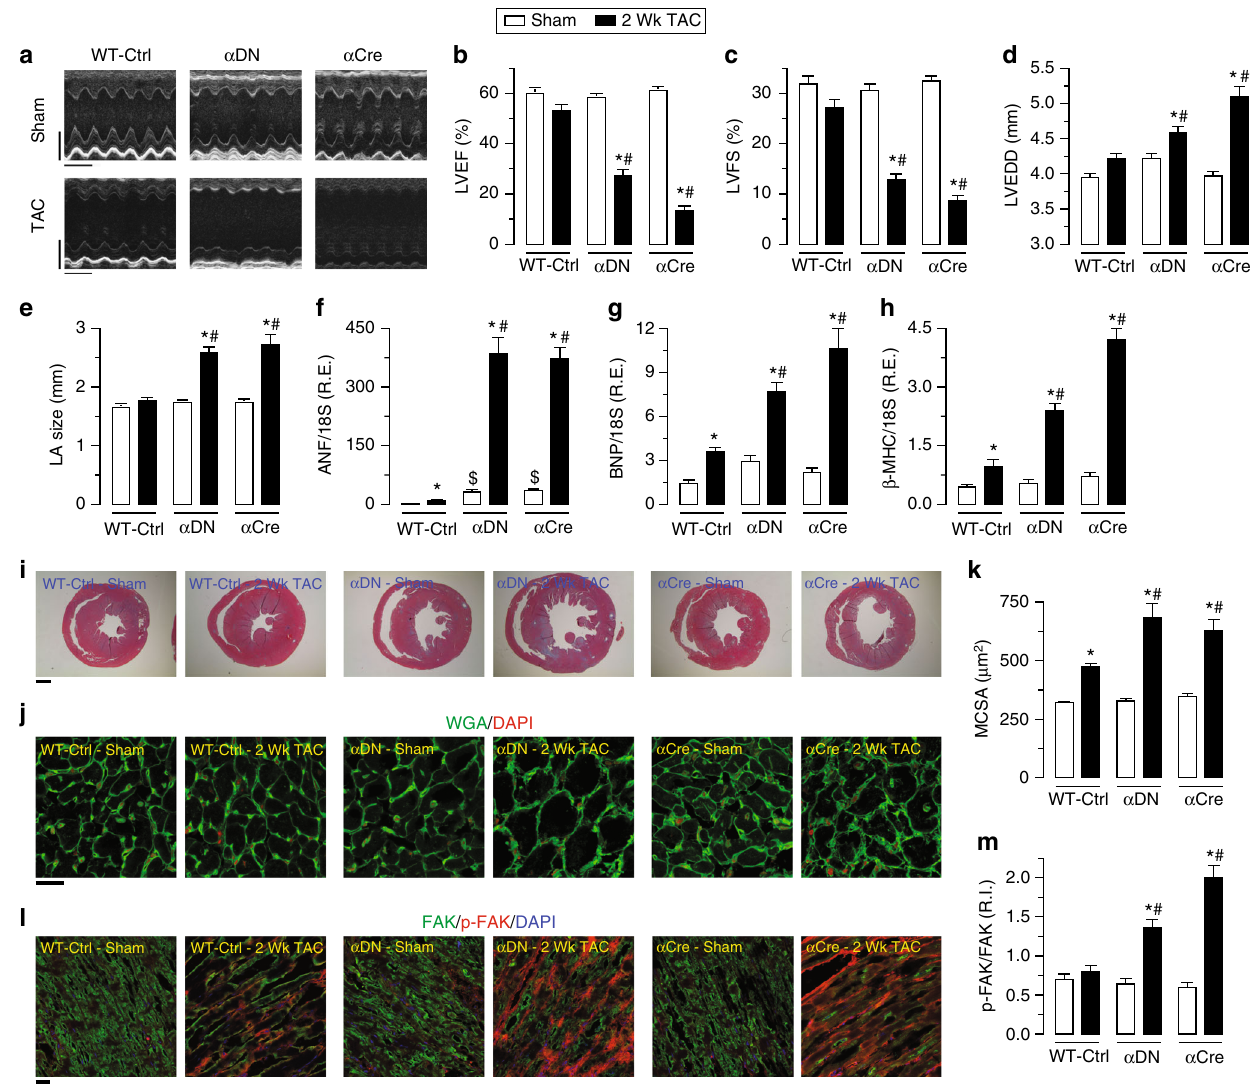
Fig. 6 Loss of p110 α leads to accelerated HF in response to pressure overload. a – e Representative M-mode echocardiography images of LV ( a ) and quanti fi cation of cardiac function showing severely decreased LVEF ( b ) and LVFS ( c ) along with increased LV end-diastolic dimension (LVEDD; d ) and left atrium (LA) size ( e ) in p110 α transgenic mice, α DN (PI3K α DN) and α Cre (PI3K α fl x/ fl x Cre), in response to pressure overload-induced biomechanical stress, compared with preserved cardiac function in the WT mice. f – h Taqman real-time PCR analyses showing a greater increase in mRNA expression of cardiac disease markers including ANF ( f ), BNP ( g ), and β -MHC ( h ) in p110 α transgenic mice compared with the WT mice in response to pressure overload for 2 weeks. i – k Histological analyses by Masson trichrome staining ( i ) and WGA staining ( j ) showing a greater increase in ventricular dilation ( i ), cardiac fi brosis ( j ), and myocyte cross-sectional area ( j , k ) in p110 α transgenic mice compared with the WT mice in response to pressure overload. l , m Representative IF staining images showing unchanged phosphorylation of FAK in WT LVs, in contrast to signi fi cantly increased phosphorylation of FAK in p110 α transgenic LVs in response to pressure overload (Fig. 3d – f). Data represent means ± s.e.m. * P < 0.05 compared with the respective Sham groups, # P < 0.05 compared with WT-Ctrl — 2 Wk TAC group as determined by one-way ANOVA analysis ( b – h , k , m ). Biological replicates: n = 12 ( a – e ), n = 10 ( f – h ) and n = 4 ( i – m ). Scale bars show 2 mm ( y -axis of a ), 200 ms ( x -axis of a ), 1 mm ( i ), and 25 µ m ( j , l Supplementary Figs. 13d, e and 14, and Supplementary Data 1).